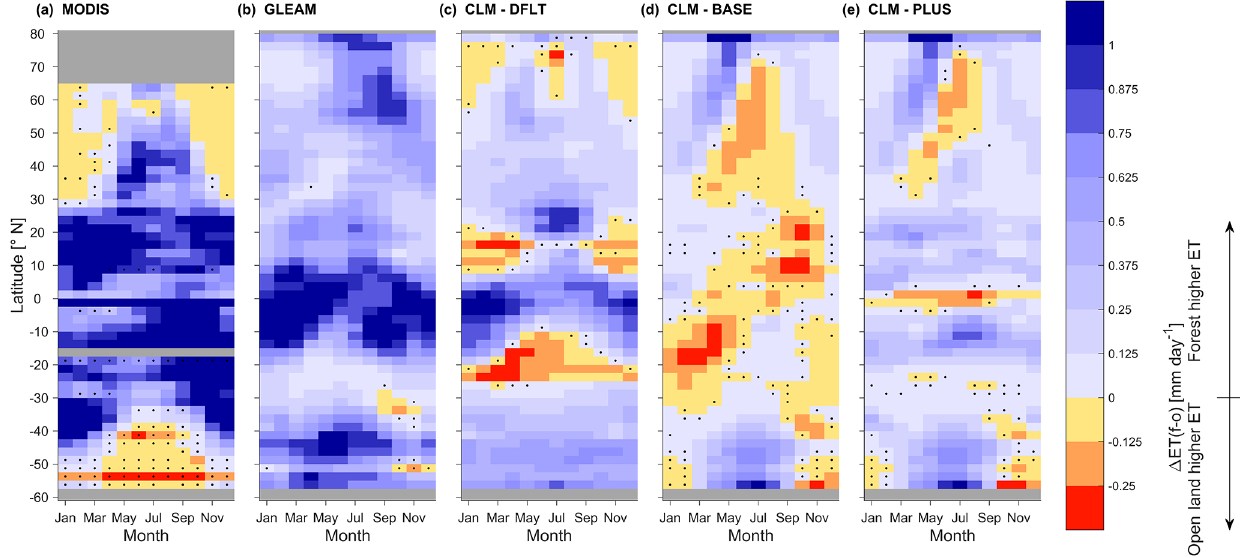
Figure 6. Seasonal and latitudinal variations of (cid:49) ET (f − o) in (a) the MODIS and (b) GLEAM observations, (c) CLM-DFLT, (d) CLM- BASE, and (e) CLM-PLUS. Points with a mean which is insignificantly different from zero in a two-sided t test at 95% confidence level are marked with a black dot. All data from the 2002–2010 analysis period corresponding to a given latitude and a given month are pooled to derive the sample set for the